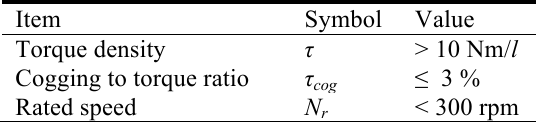
Table 2: Design targets in new